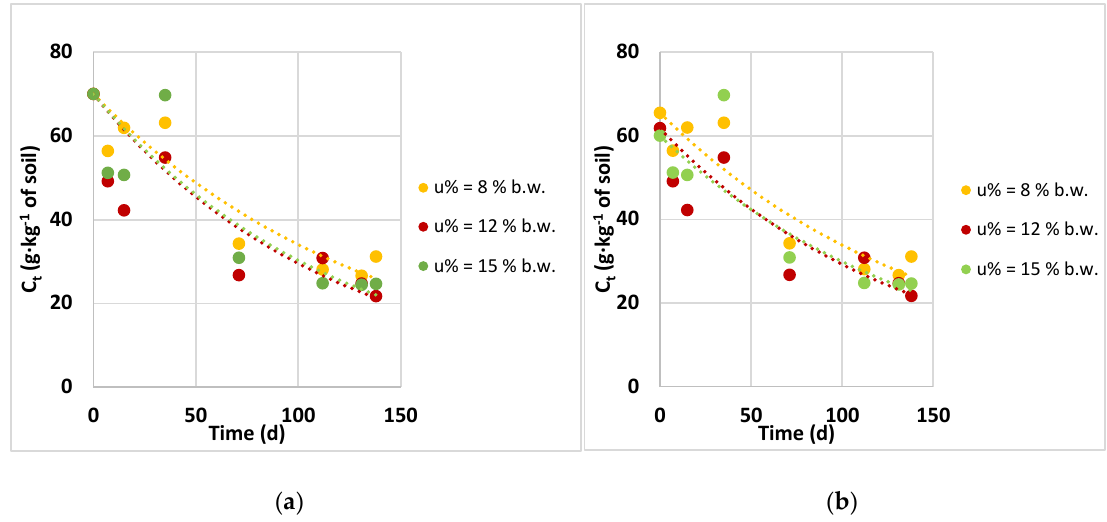
Figure 9. First-order model for microcosms with C / N = 180: ( a ) C 0 = 70 g · kg − 1 of soil; ( b ) C 0 was measured.